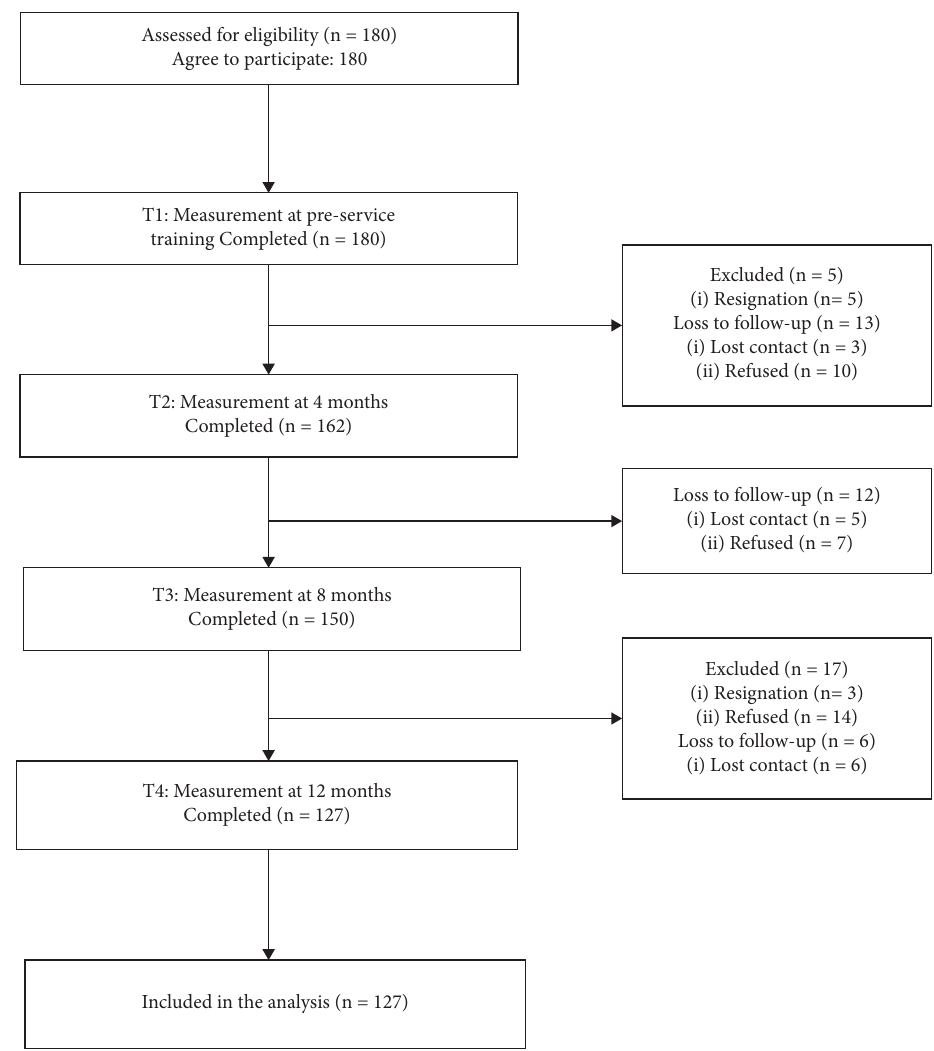
Figure 1: Te recruitment process and the fow of the